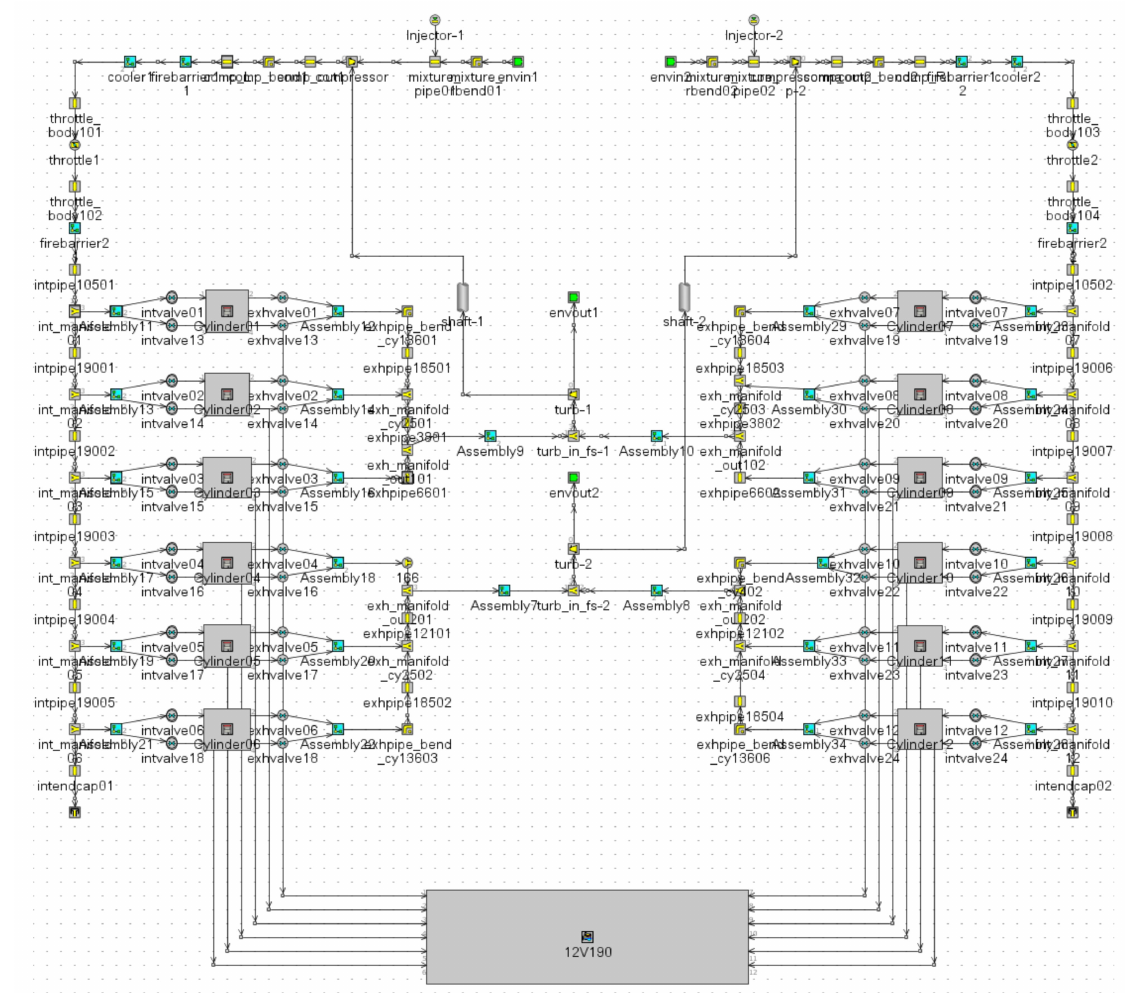
Figure 2. Full engine model in GT −